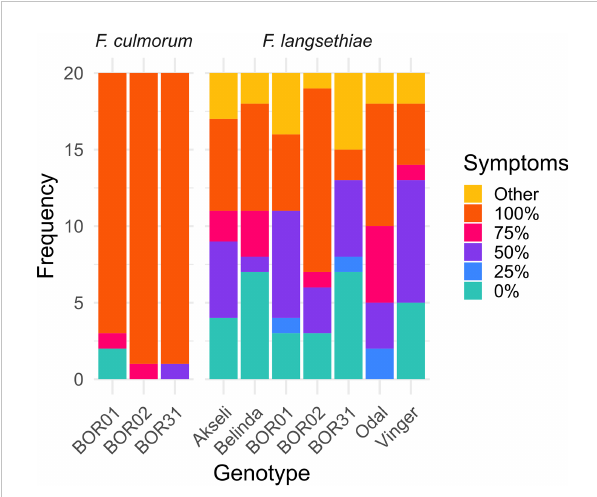
FIGURE 3 Visual assessment of infection incidence and symptoms on the spikelets by the different treatments at 7 days post infection. The frequencies of spikelets with different percentage of symptomatic tissue are shown as stacked bar plots. The symptomatic percentage was assessed qualitatively by visual scoring and grouped as 0%, 25%, 50%, 75%, and 100% symptomatic tissue, and other damage (yellowing, dark spots). This analysis represents the visual scoring of 20 spikelets per genotype per treatment from batch 2.